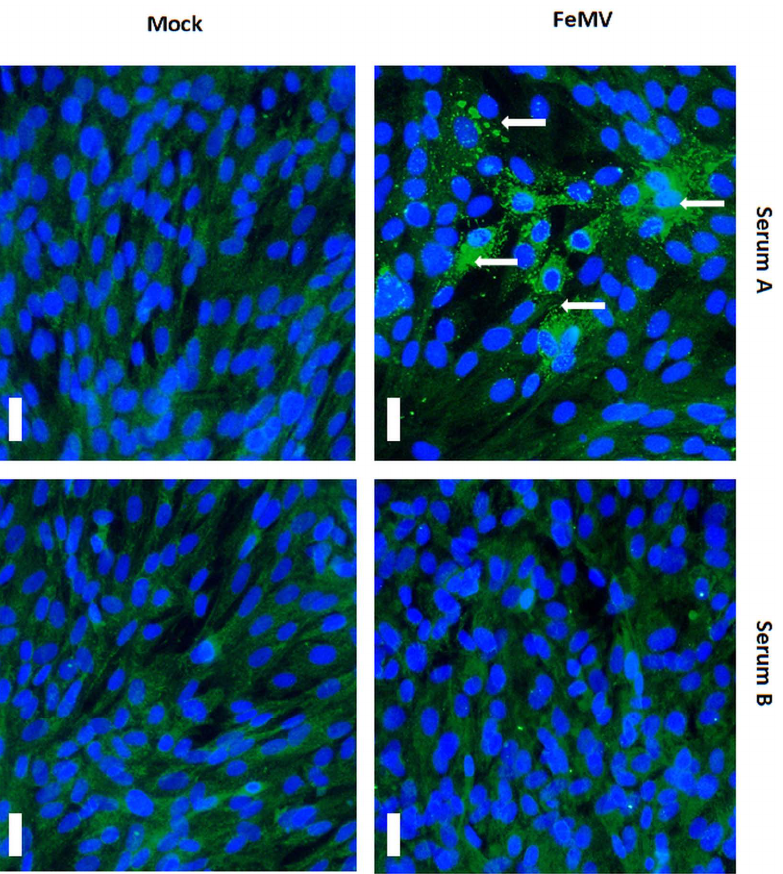
Figure 3. Serology of analyzed guigna serum samples from Chile. Representative result of a serological analysis via immunofluorescence assay. FeMV-specific antibodies were detected in a guigna serum sample (serum A) illustrated by fluorescence staining of perinuclear and cytoplasmic viral inclusion bodies (white arrows). In comparison, an IFA-negative sample (serum B) is shown on the right. Scale bar represents 20 µ